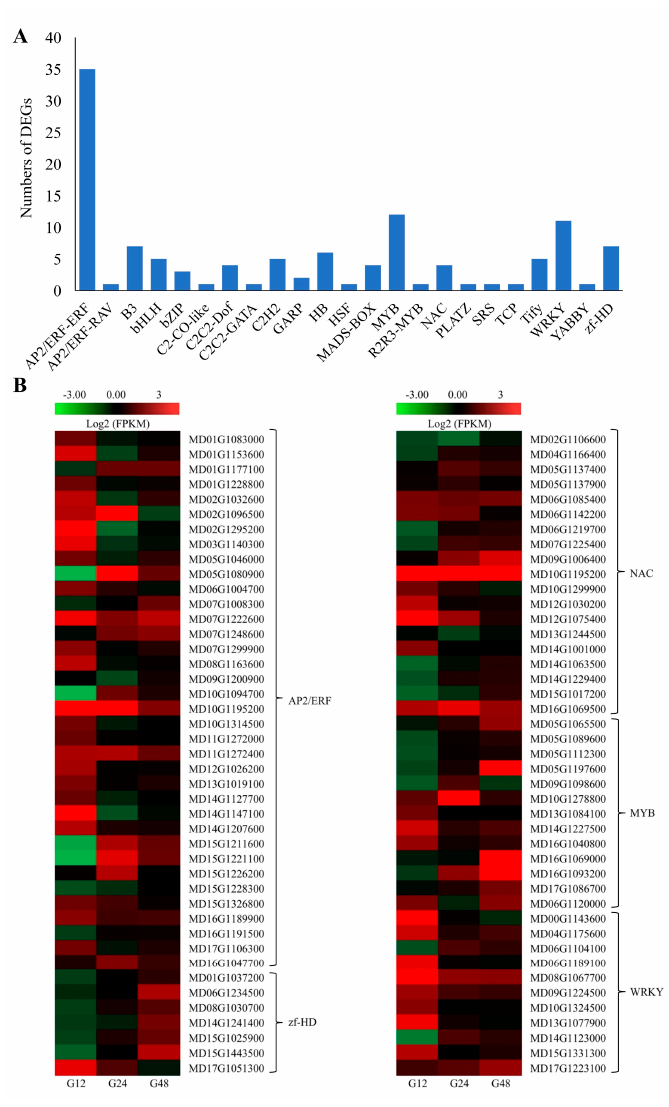
Figure 4. Transcription factors (TFs) in the differentially expressed genes (DEGs) sets. ( A ) Number of DEGs in different TF families; ( B ) expression profiles of genes from different TF families. The maximum/minimum log 2FPKM value was set to ± 3.0 (red for upregulated, green for downregulated), each horizontal row represents a DEG with its gene ID, and the vertical columns represent 12, 24 and 48 hpi from left to right.